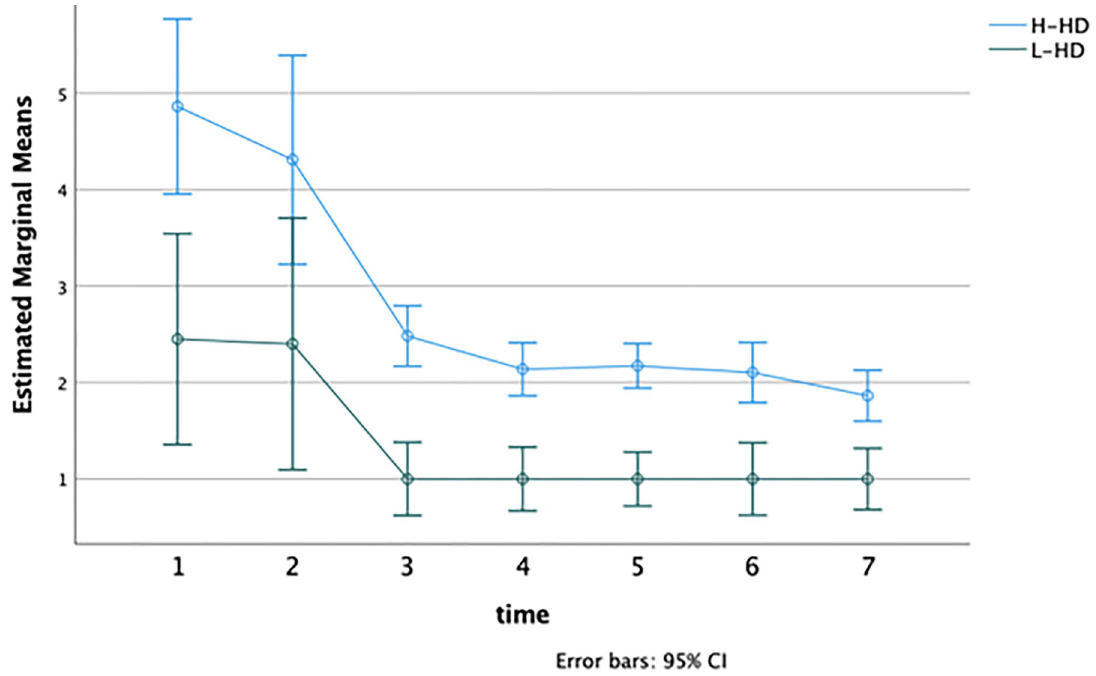
Fig 2. Frequency of thoughts object-related referred each day respectively for H-HD and L-HD. Notes : H-HD: group of individuals with higher hoarding features; L-HD: group of individuals without hoarding features; Time 1–7: number of the day.